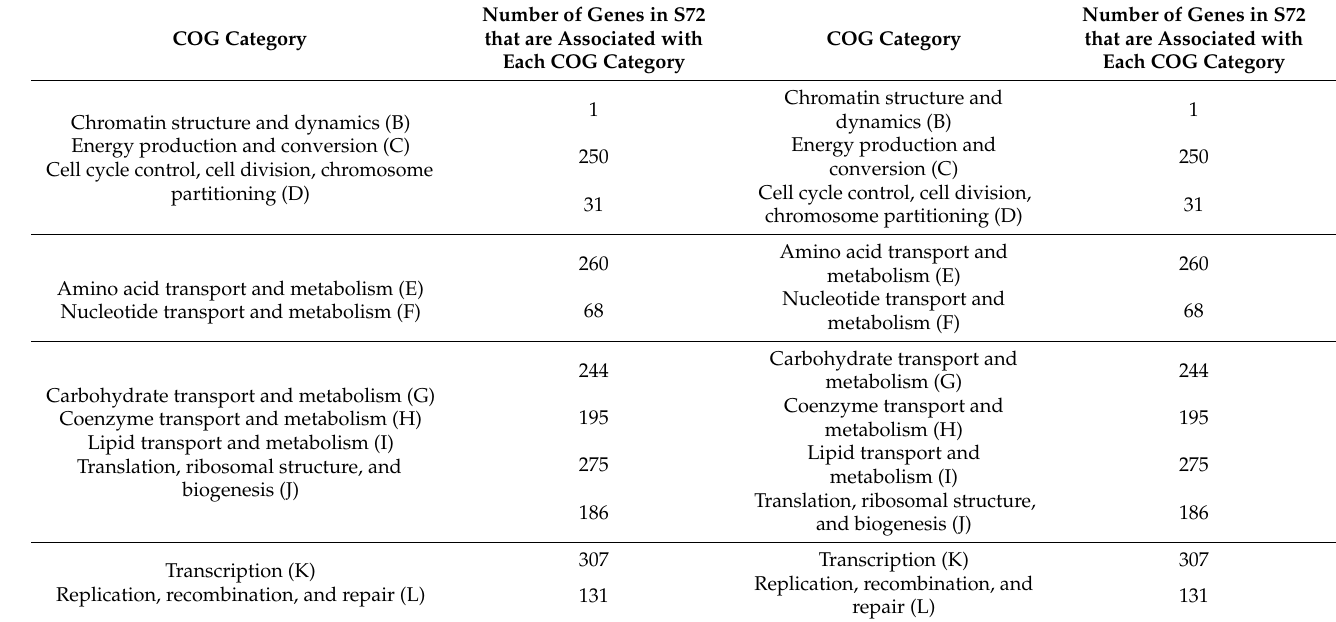
Table 2. Gene distribution in different COG categories in S72.